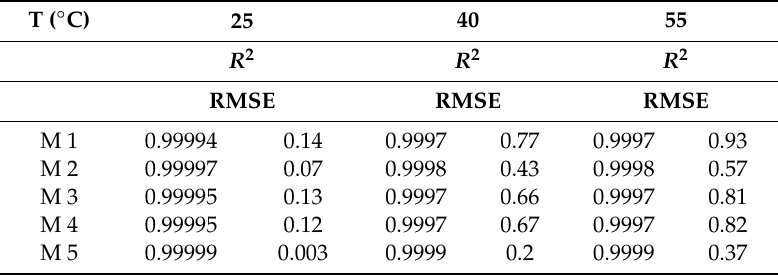
Table 5. Values of determination coe ffi cients R 2 and RMSE for the tested isotherms models for the adsorption of CV on MNP / CTAB–EC